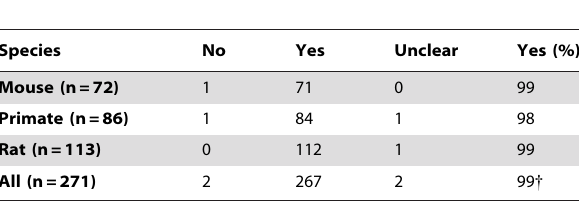
Table 19. Number of studies presenting numerical data.